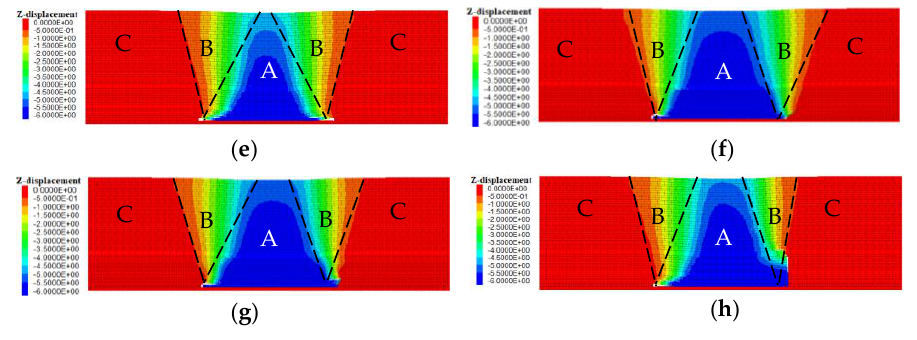
Figure 9. Distribution of displacement field of overburden